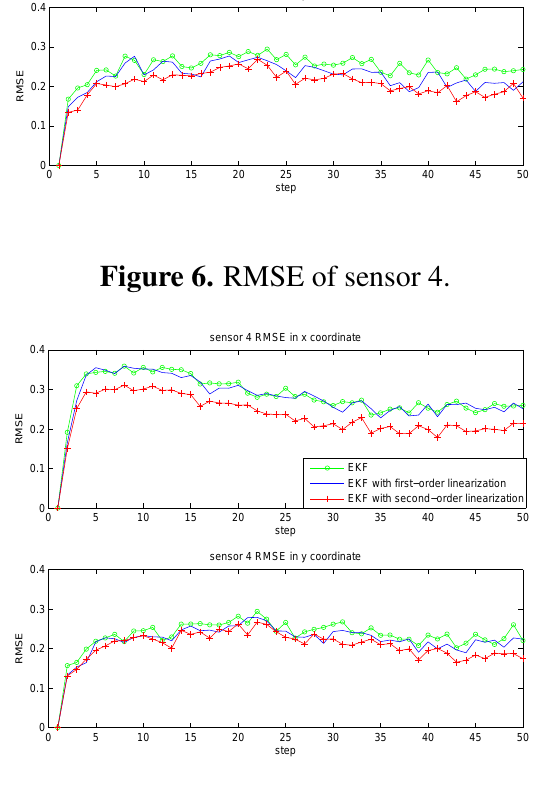
Figure 6. RMSE of sensor